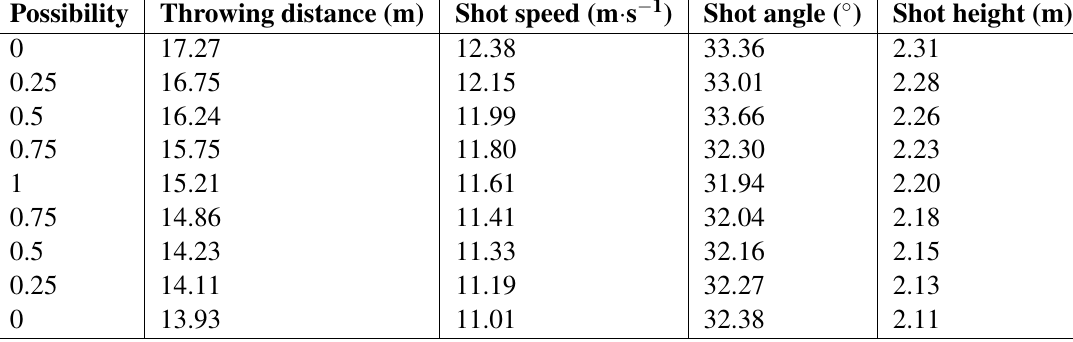
Table 4 List of athletes’ best throwing mode and throwing